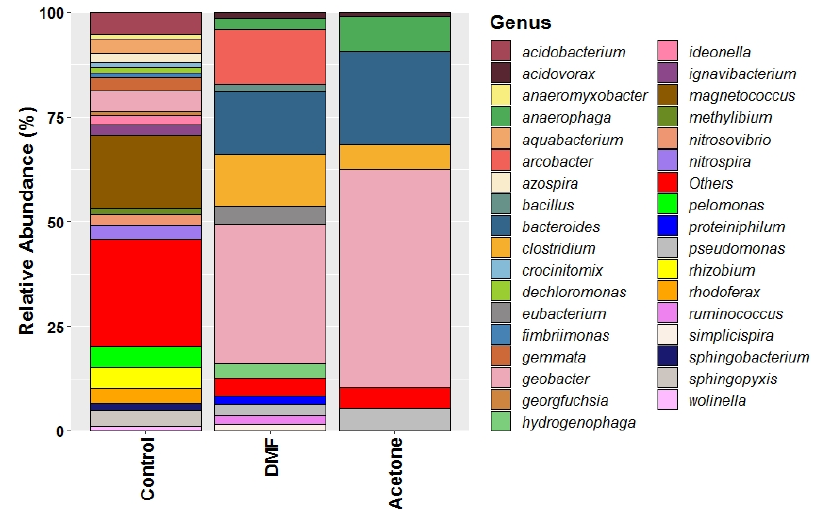
Figure 6. Taxonomic classification at genus level for the three samples. The genera represented by less than 1% of relative abundance have been grouped in “others”.